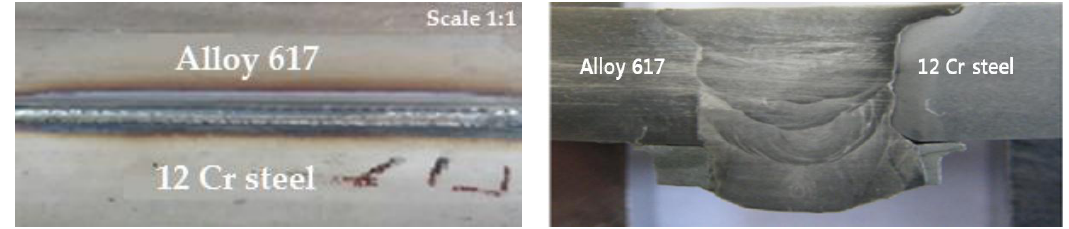
Figure 3. Dissimilar weld: top view ( left ) and cross section ( right ).